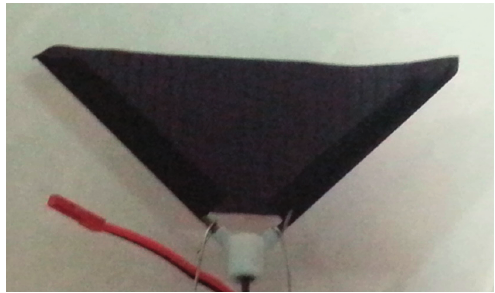
Figure 58. Prototype 2 tail.